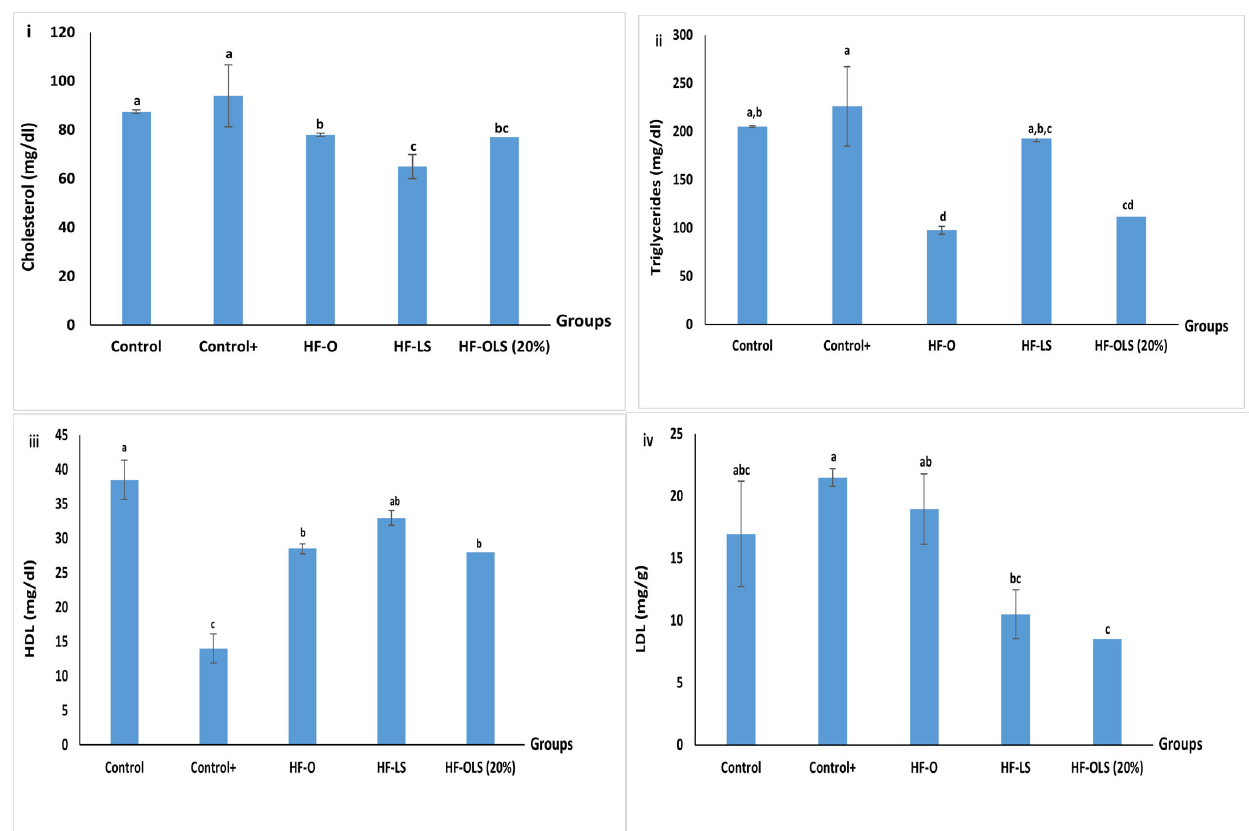
Figure 9. Lipid profile—( i ) cholesterol (mg/dL), ( ii ) triglycerides (mg/dL), ( iii ) HDL (mg/dL), and ( iv ) LDL (mg/dL)—of rats fed with standard diet, high fat diet, and high fat diet and juice for three months. Control (rats fed with a standard diet), Control+ (rats fed with a high ‐ fat diet composed by mixing a standard diet with 20% of vegetarian ghee), HF ‐ O (rats fed with a high ‐ fat diet and 9 mL/kg/day of orange juice), HF ‐ LS (rats fed with a high ‐ fat diet and 9 mL/kg/day of beetroot leaf– stem juice), HF ‐ OLS (20%) (rats fed with a high ‐ fat diet and 9 mL/kg/day of orange juice mixed with 20% of beetroot leaf–stem juice). Columns labeled with different letters are significantly different at p < 0.05.